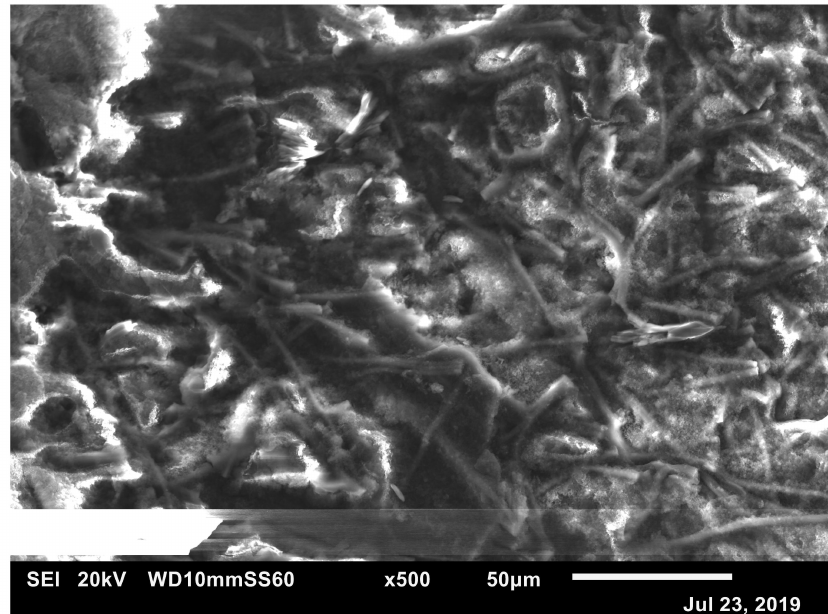
Figure 3. Scanning electron microscopic image showing the morphology of the hydrothermally carbonized coating from the sugar solution.